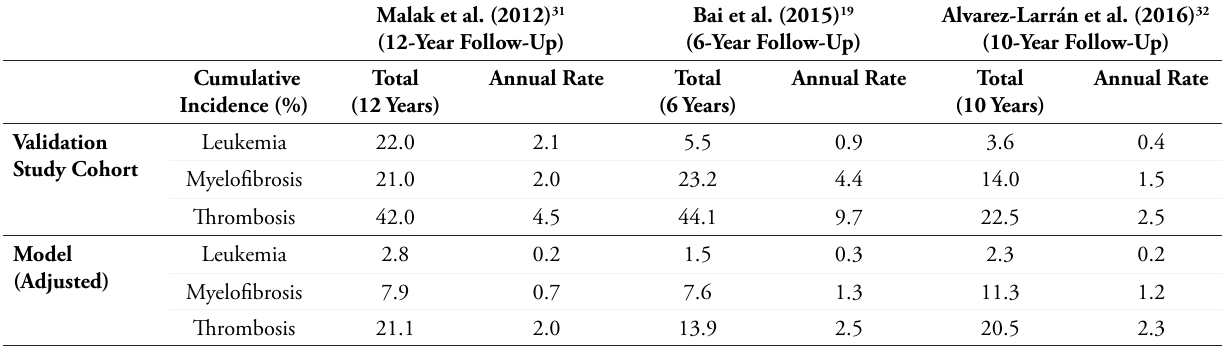
Table 4. Cumulative Incidence in Percent and Annual Rate of Disease Progression, Model, and Study